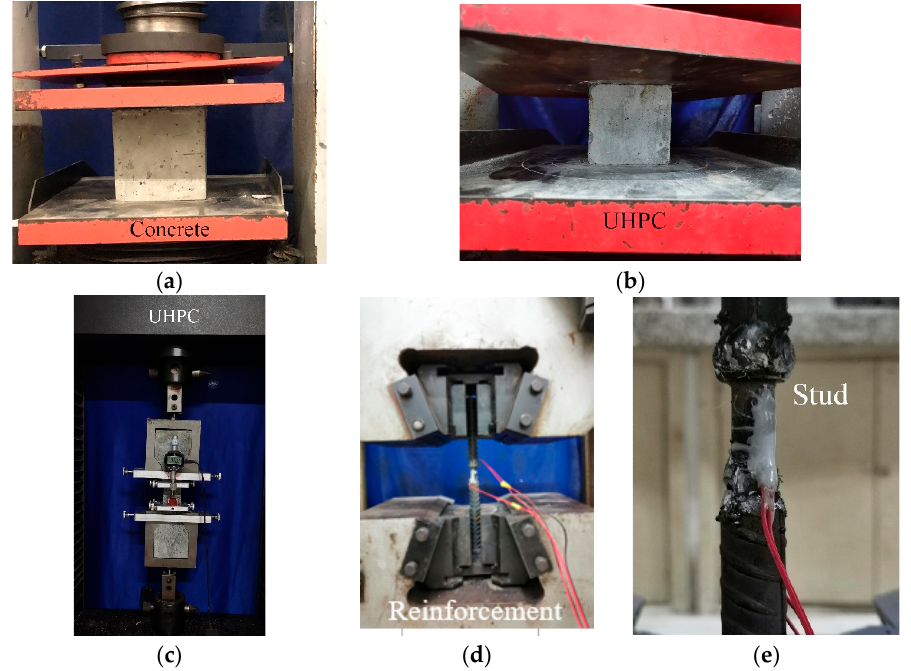
Figure 7. Testing of material properties:( a ) Concrete; ( b ) UHPC; ( c ) UHPC; ( d ) Reinforcement; ( e ) Stud. ( e )